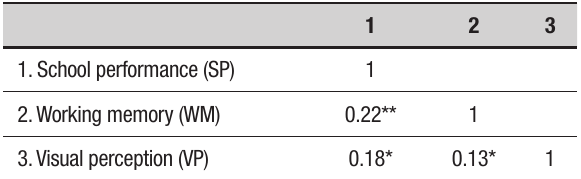
Table 4. Correlation between school performance, visual perception and working